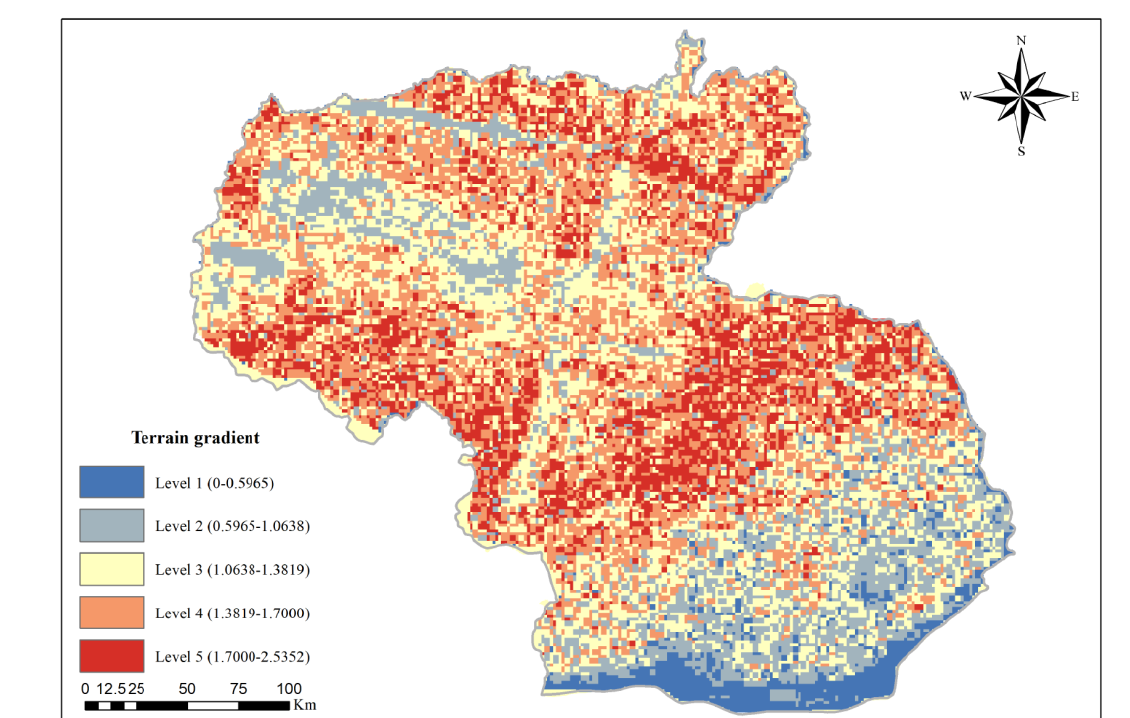
Figure 2. Terrain gradient pattern of Shannan.